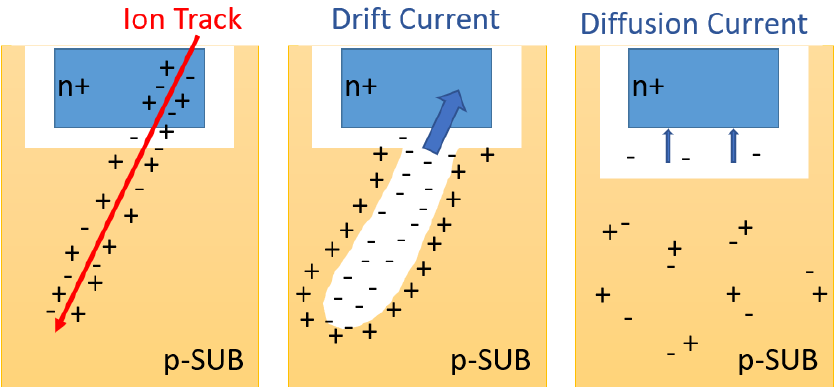
Figure 1. This figure shows the phases of an ion strike on a p-n junction. ( left ) The ion generates e- h pairs, releasing its energy. ( centre ) The electron and holes are generated, and a drift current is observed. ( right ) The diffusion current dominates the